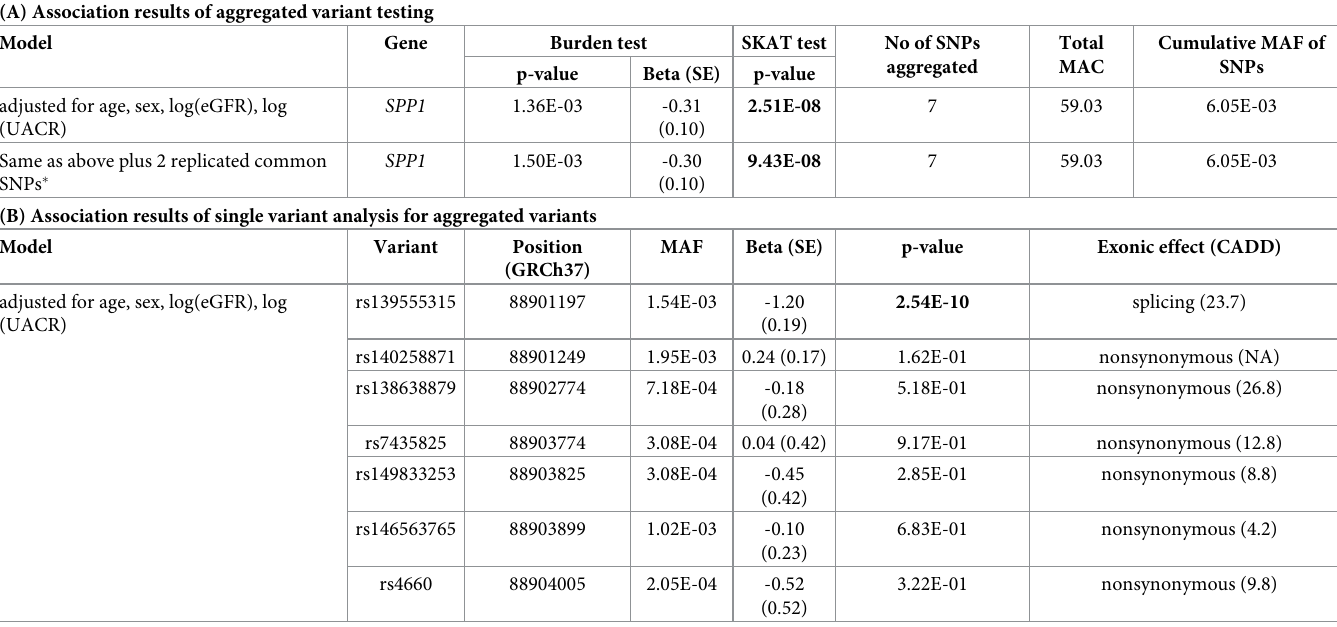
Table 3. Association results for SPP1 (chromosome 4) for the rare variant analysis. (A) Association results of aggregated variant testing